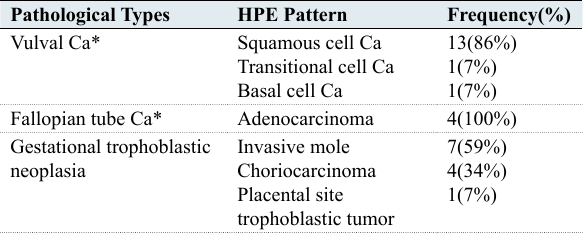
Table 4: Histopathological pattern of other malignancies